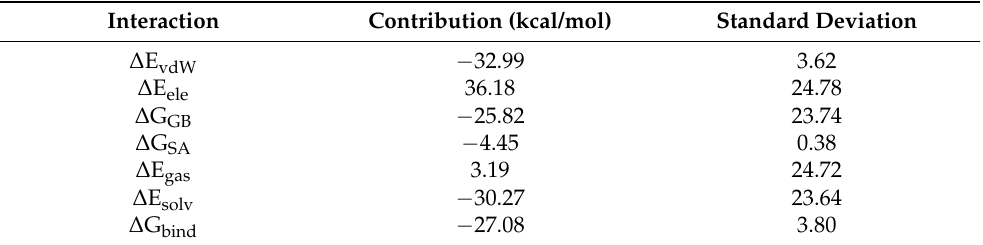
Table 5. Binding free energy of the system and energy contribution of each component.